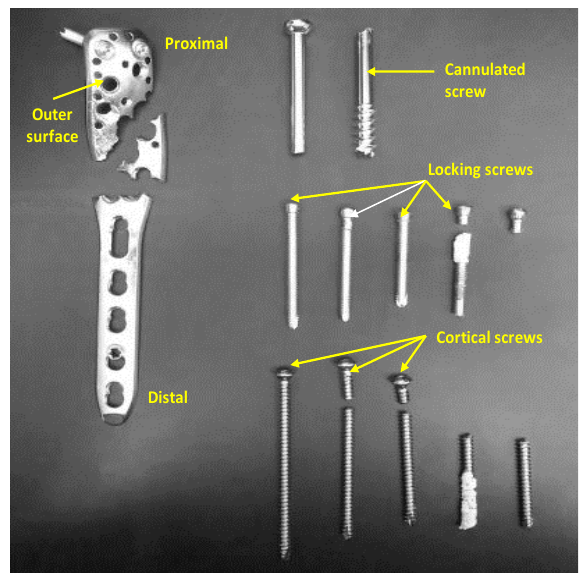
Figure 1. PHILOS Plating System failed parts .